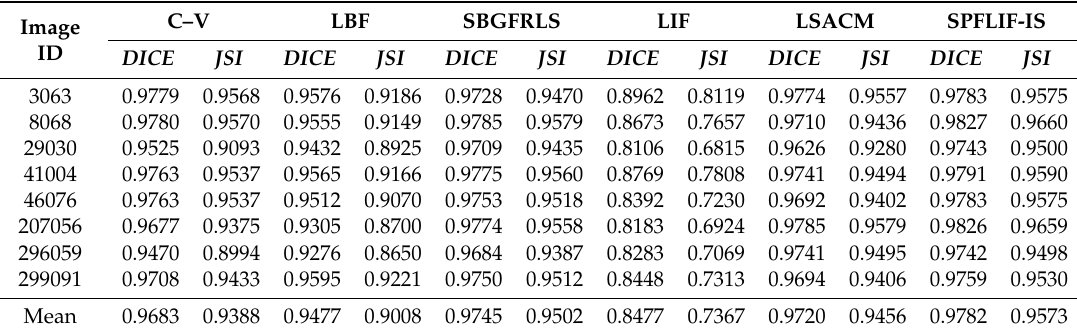
Figure 7. JSI values of the image segmentation results using the four models for Berkeley color images. Table 7. DICE and JSI values of the results of image segmentation on fifteen Berkeley color